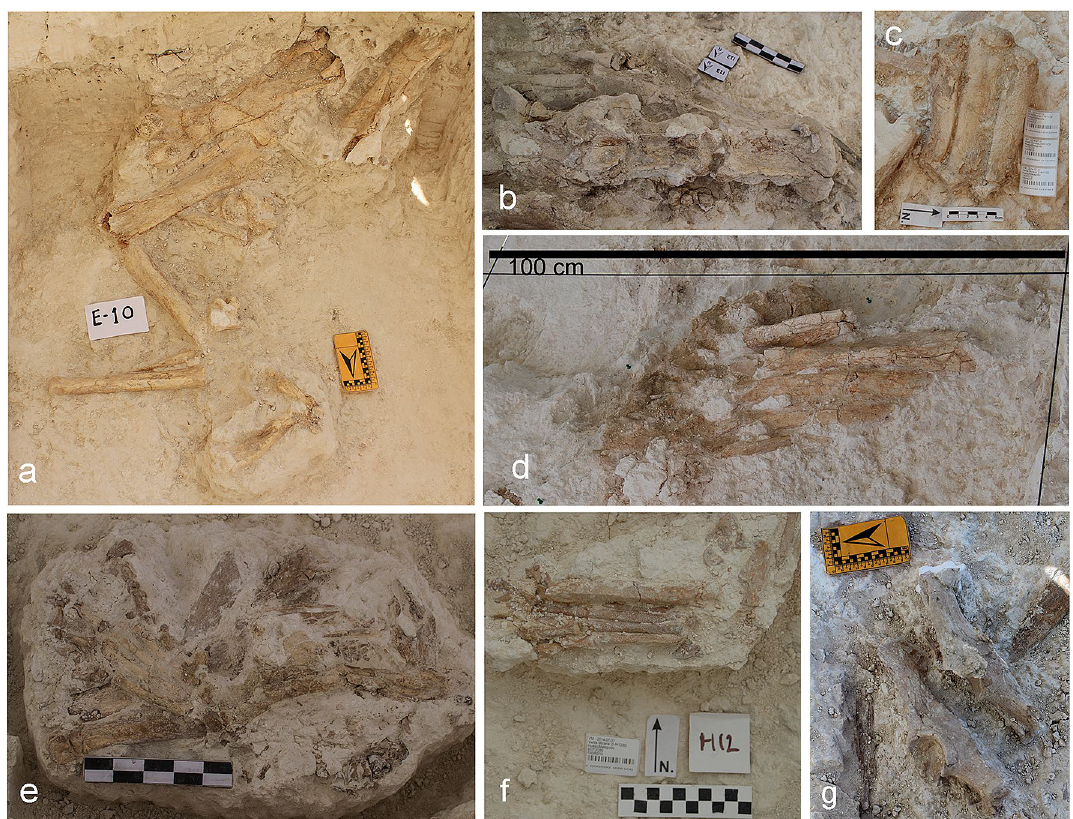
Figure 6. Several elements found in anatomical connection in the excavation quarry VM4 of Venta Micena. ( a – c ) Stephanorhinus aff. hundsheimensis [hindlimb ( a ); axis, first, and second cervical vertebrae ( b ); second, third, and fourth metacarpals ( c )]. ( d ) Group of five dorsal vertebrae of elephant Mammuthus meridionalis. ( e ) Forelimb of an indeterminate felid of small size. ( f ) Hindlimb of a large-sized canid. ( g ) Two hemipelves of horse Equus